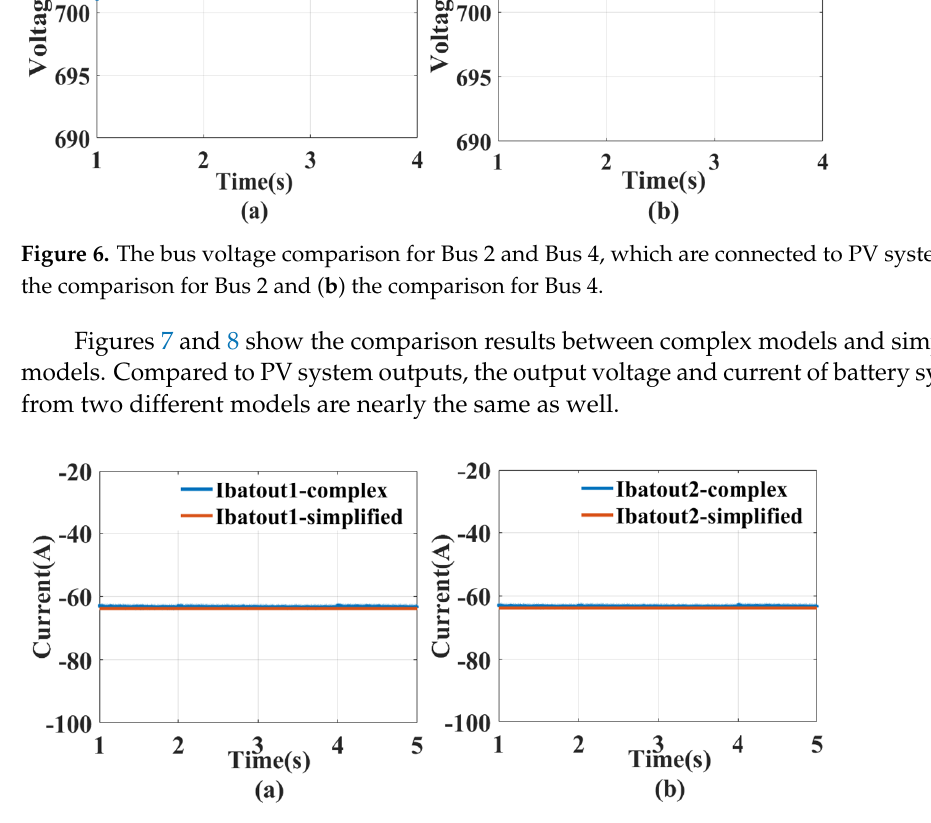
Figure 7. The output current comparison for battery system: ( a ) the comparison for battery system 1 and ( b ) the comparison for battery system 2.